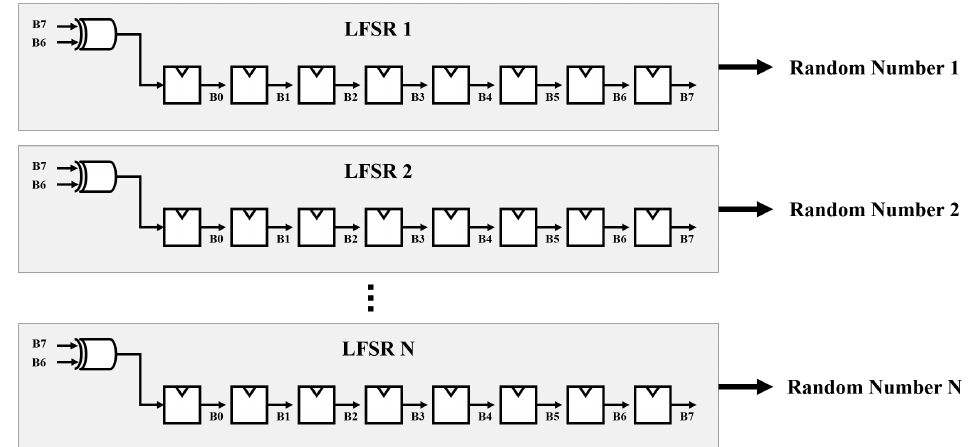
Figure 10. Employing multiple LFSRs to obtain multiple random numbers at the same time.